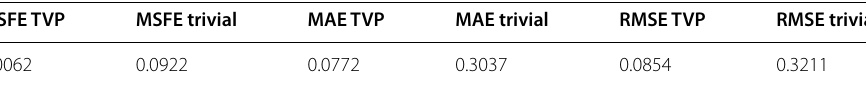
Table 6 Model efficiency summary for Alibaba